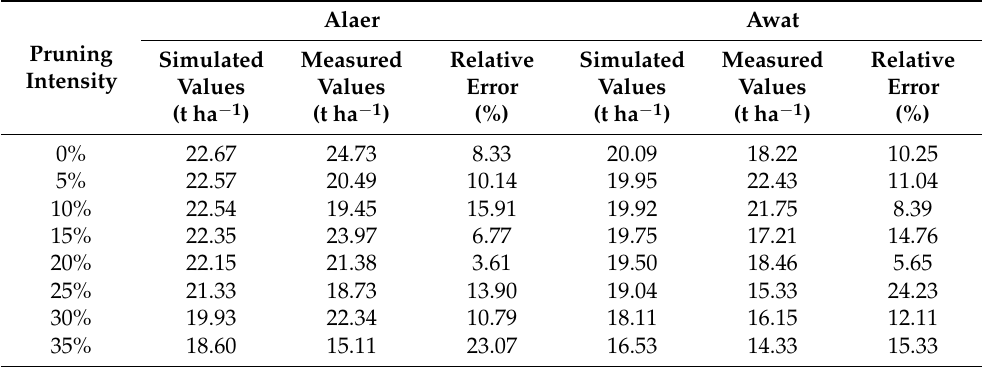
Table 5. Simulated and measured values of final TAGP for different treatments based on modi- fied